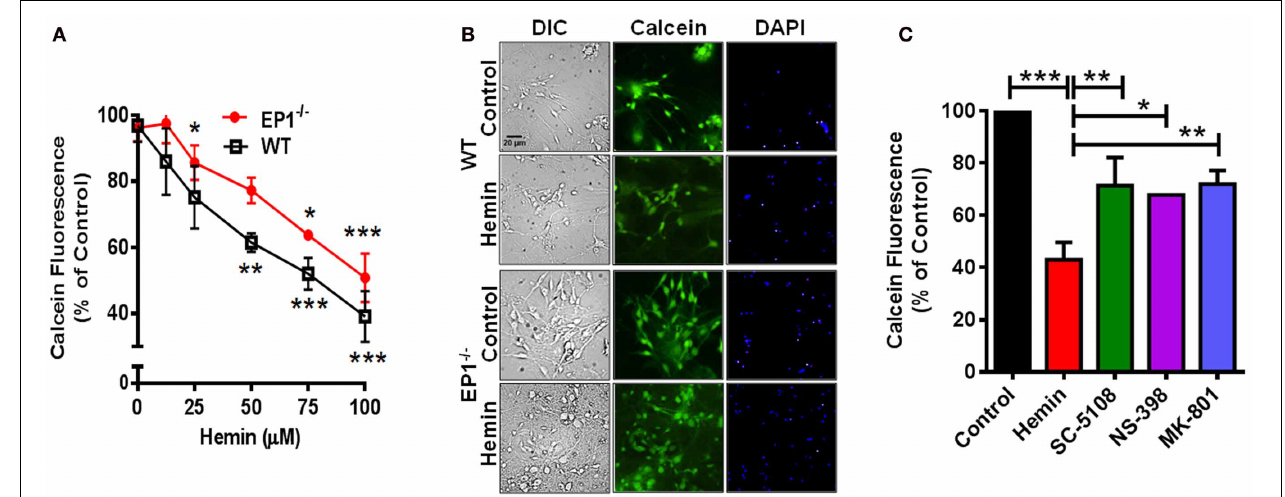
phase-contrast images using a 20 × DIC objective. (C) Cultured WT neurons were pre-treated with SC51089 (10 μ M), NS-398 (10 μ M) and MK-801 (10 μ M) for 15min and then co-treated with hemin (75 μ M). After 18h of treatment, live cells were measured using the Calcein AM assay. Calcein AM assay data represent means ± SEM of duplicate measures from triplicate wells from four experiments. Statistical analysis was carried out using One-Way ANOVA, with Bonferroni’s multiple comparison tests. ∗∗∗ p < 0 . 001 vs. control; ∗∗ p < 0 . 01 and ∗ p < 0 . 05 vs. hemin